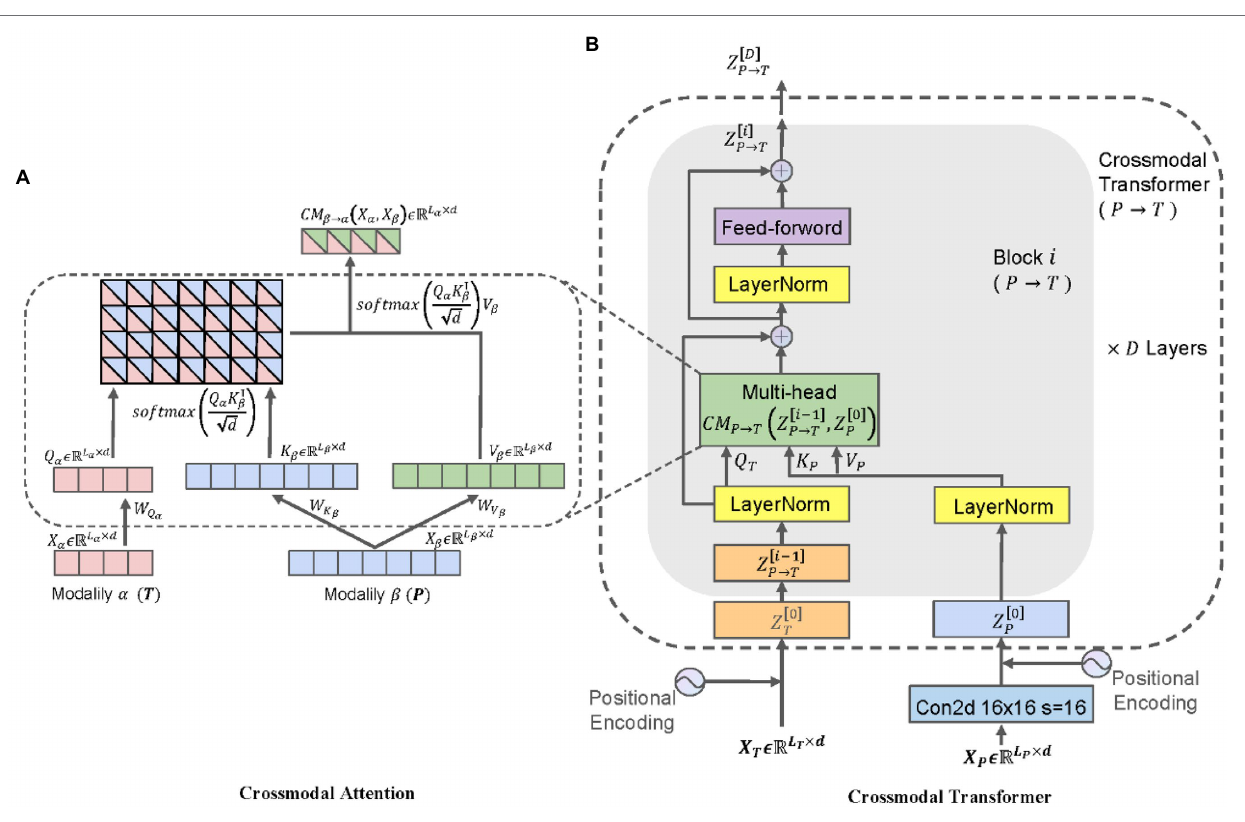
FIGURE 3 | The overall structure of Cross-Modal